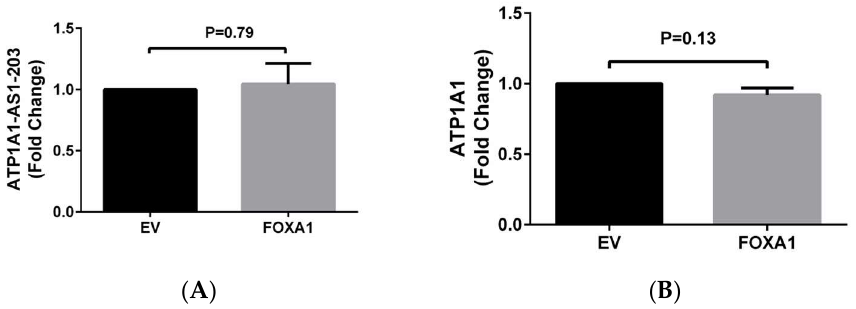
Figure 4. The effect of FOXA1 overexpression on ATP1A1-AS1 expression in HK2 cells. A pcDNA3.1(-B) plasmid that overexpresses FOXA1 (FOXA1) or empty vector (EV) was transiently transfected into HK2 cells for 48 h, an empty pcDNA3.1(-B) plasmid was used as control. The expression of ATP1A1-AS1-203 ( A ) and ATP1A1 ( B ) were measured using RT-qPCR. These experiments were repeated six times. Data was analyzed using t -test.